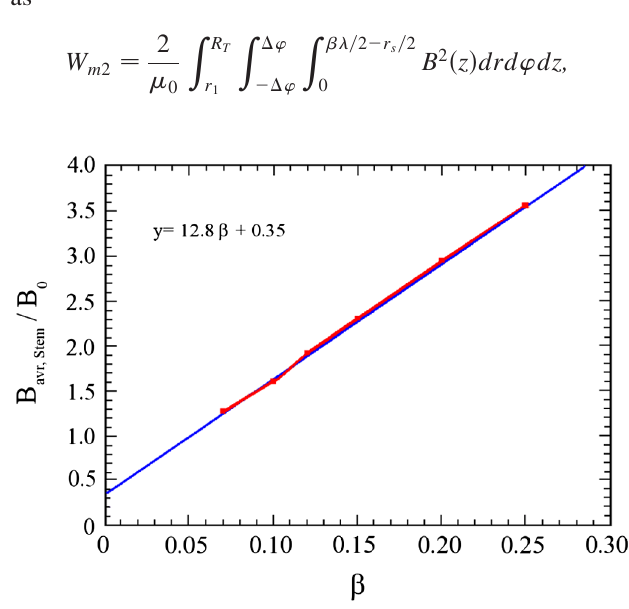
FIG. 11. Enhancement of the magnetic field in the vicinity of the stems as a function of the geometrical cavity (cid:2) . The red dots are results of simulations and the blue curve is a linear fit.FIG. 10. B 2